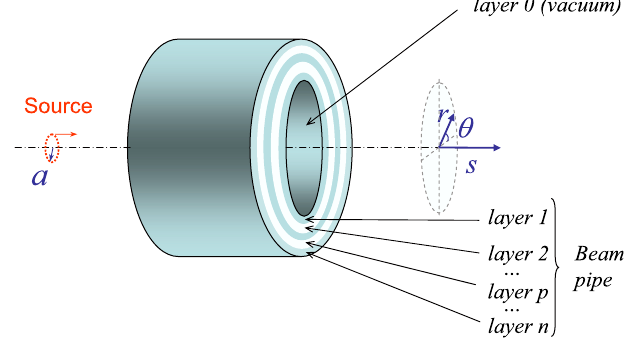
FIG. 1. (Color) Geometry of the beam